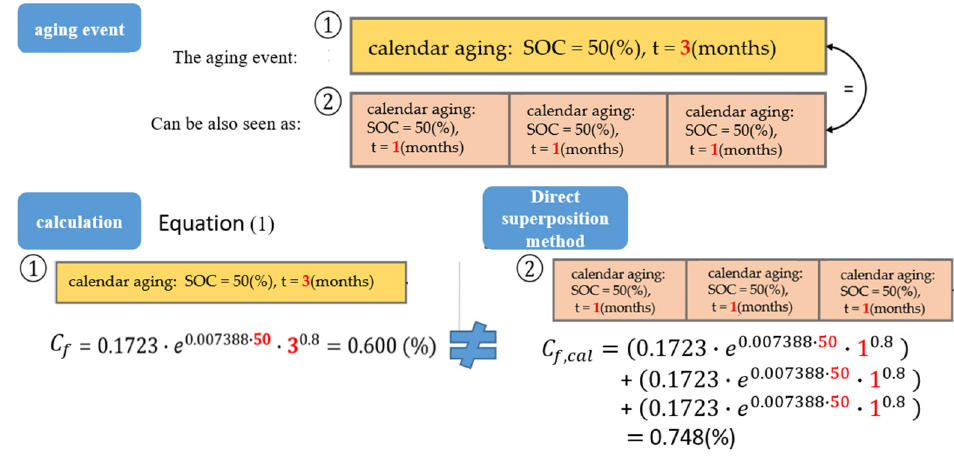
Figure 10. A schematic diagram for direct superposition.